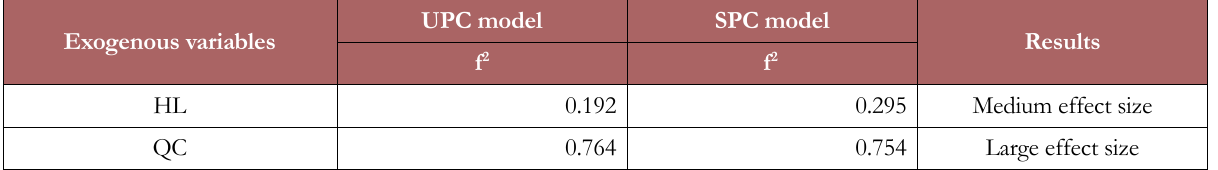
Table 10. Effect size f 2 of the exogenous variables